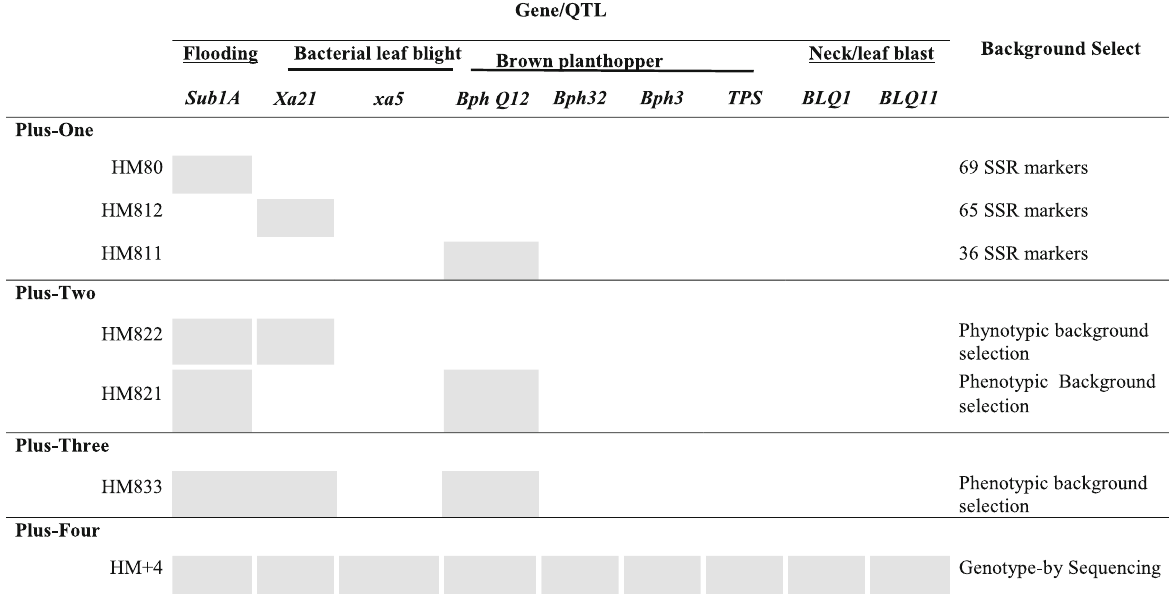
Table 2 Pyramiding nine target genes/QTLs into the KDML105 background by marker-assisted backcrossing illustrated in Fig. 2. Background selection with markers was conducted only in the Plus-1 and Plus-4 BILs. X= The gene/QTLs were added to the new varieties by